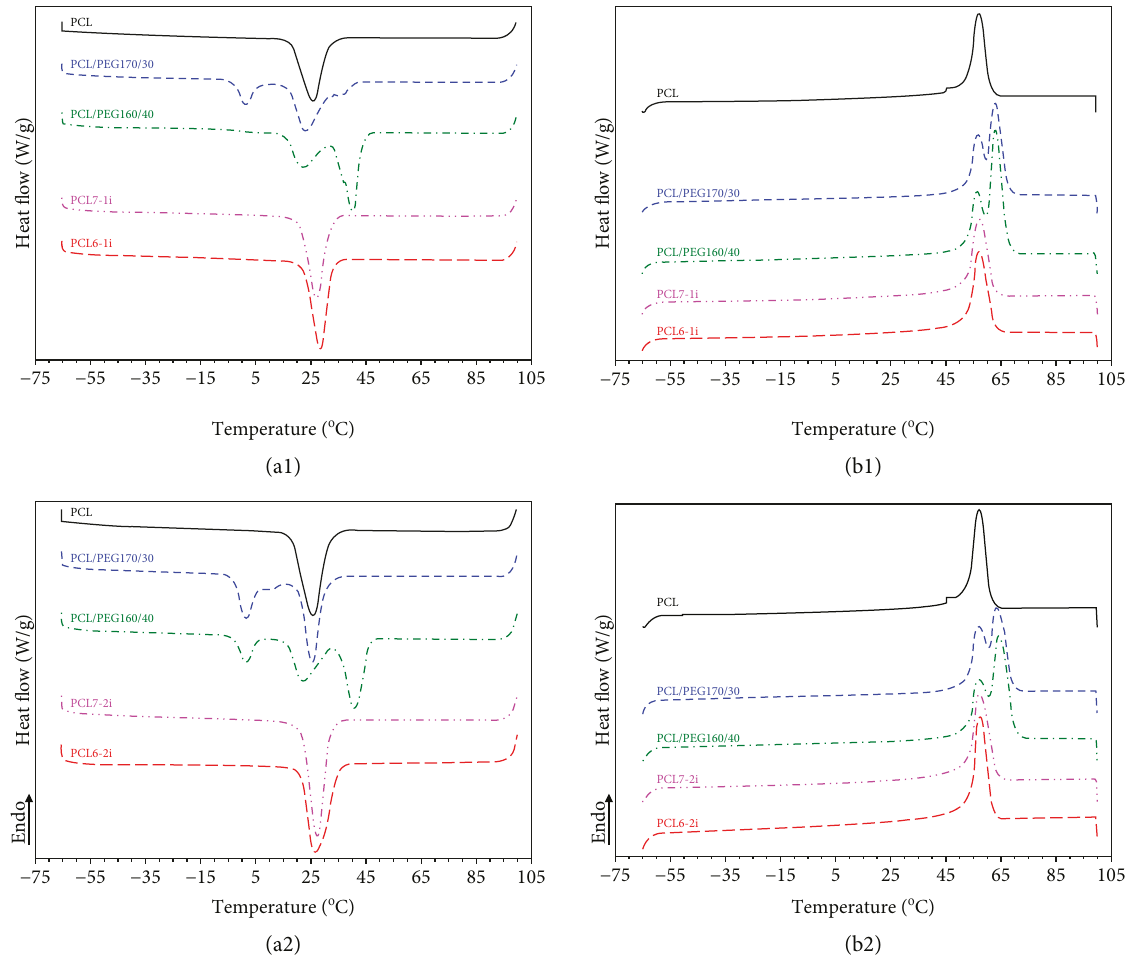
Figure 2: Comparison of DSC cooling thermograms (a1 and a2) and second heating thermograms (b1 and b2) for PCL/PEG1 (numbers 1) and PCL/PEG2 (numbers 2) samples, before and after